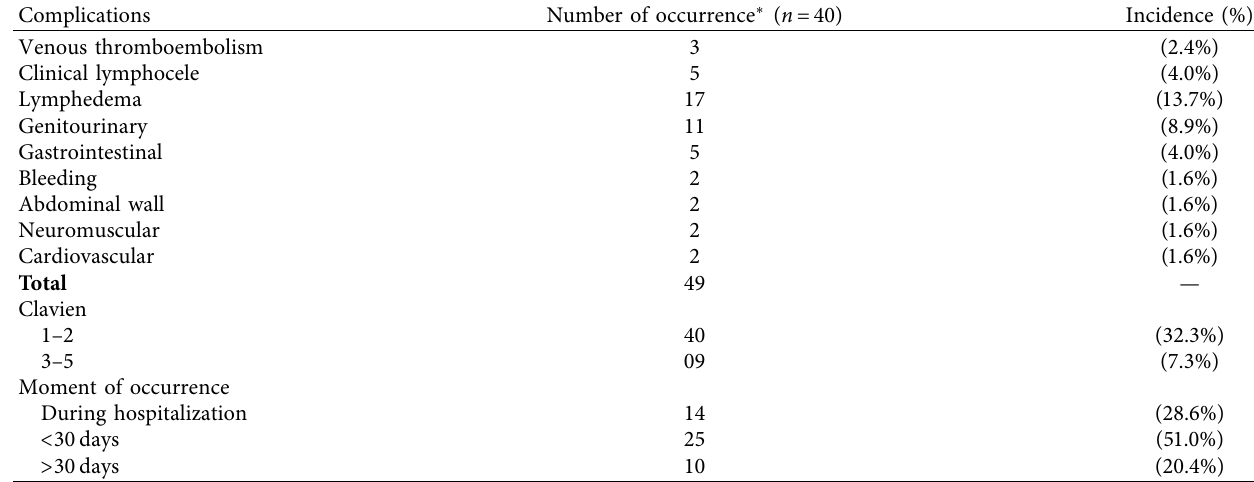
Table 4: Description of complications according to type, severity, and moment of occurrence in a cohort of 124 patients undergoing extended pelvic lymph node dissection.